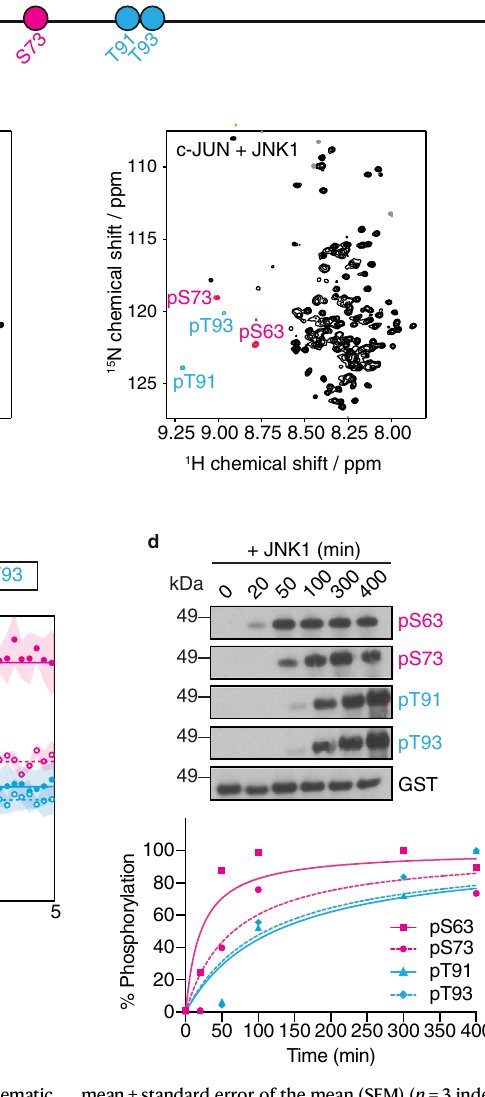
mean±standard error of the mean (SEM) ( n =3 independent samples); error bars are presented as ribbons. d Western blot analysis of the in vitro phosphorylation kinetics of recombinant c-JUN TAD by JNK1 using phosphorylation-speci fi c anti- bodies (top) and quanti fi cation of the detected protein levels at each time point usingtheImageStudioLiteSoftware(Licor)andnormalizedtototalGSTc-JUNTAD and subsequently to the maximum phosphorylation time point of each phosphorylation-speci fi c antibody (bottom). The data are representative of a minimum of three biologically independent experiments ( n =3) performed with similar results. Source data are provided as a Source Data fi